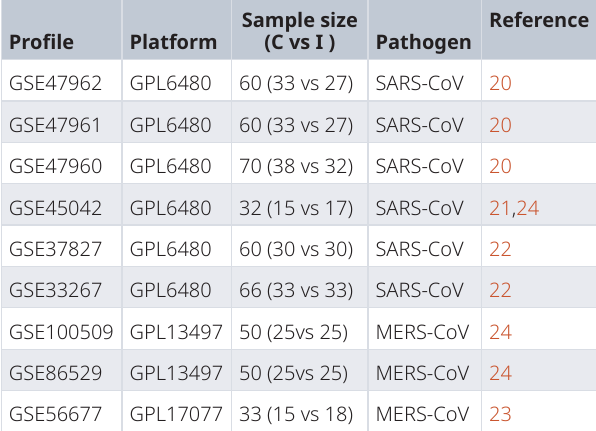
Table 1. List of microarray datasets used in this study.